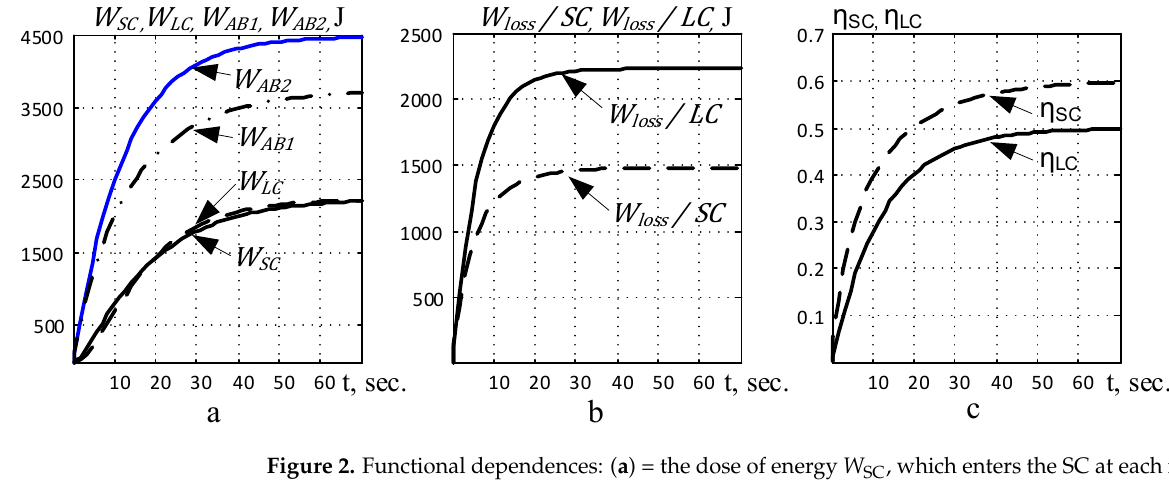
Figure 2. Functional dependences: ( a ) = the dose of energy W SC , which enters the SC at each moment of its charge and the energy dose W AB1 , which is selected from the AB; the dose of energy W LC , which enters the LC at each time of its charge and the dose of energy W AB2 , which is selected from the AB; ( b ) = energy losses W loss in the charge circuit LC and SC; ( c )—energy transfer coefficients from the AB when charging the linear capacitor η LC and supercapacitor η SC